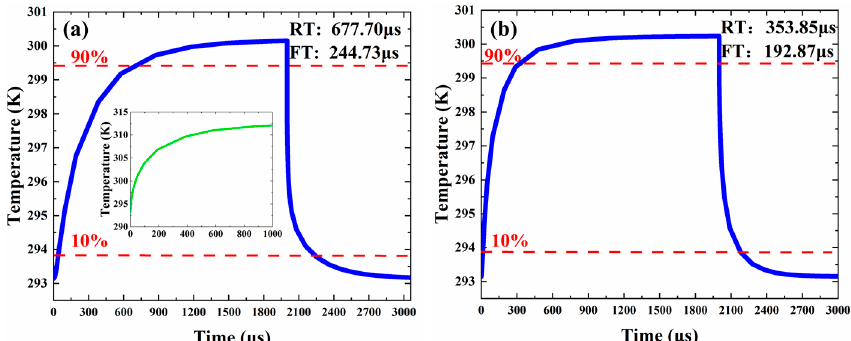
Figure 9. ( a ) The response time of the VOA with the top electrode heated. Inset: The temperature rise of the electrode over time when the input power is 29.9 mW. ( b ) The response time of the VOA with the graphene electrode heated.